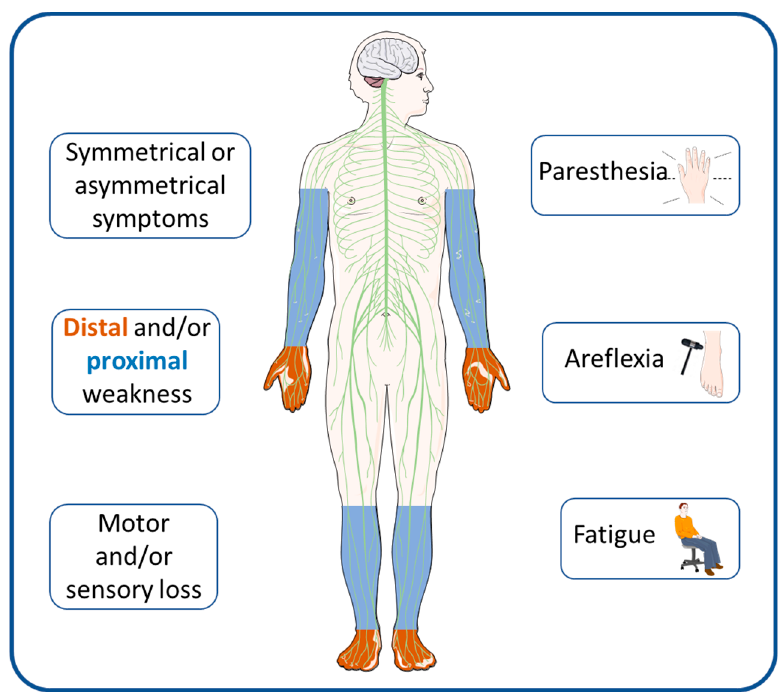
Figure 1. Common manifestations present in patients with CIDP.